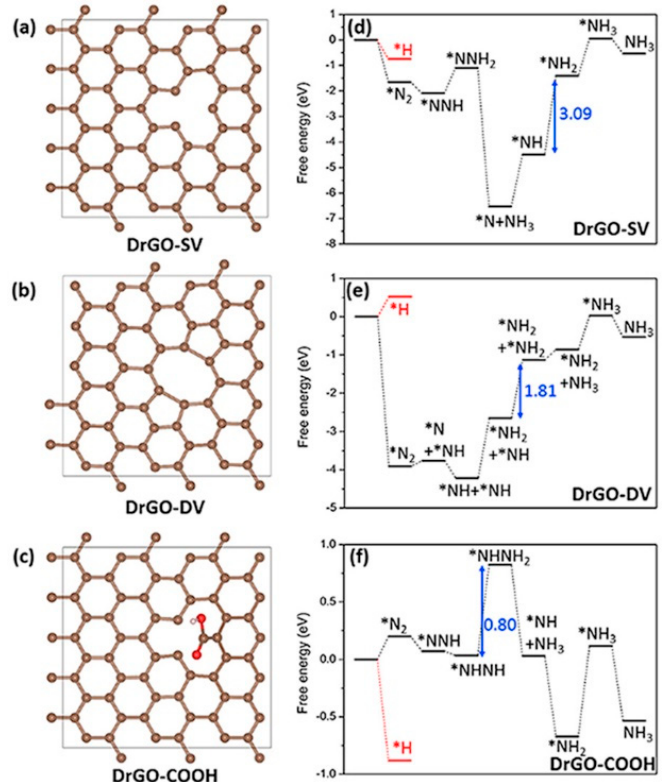
Figure 2. Different defects on DrGO: single Carbon Vacancy ( a ), double Carbon Vacancy ( b ), and carboxylic carbon ( c ). Energetics for main NRR intermediates on these defects are reported on the right side ( d – f ). Reprinted with permission from [36]. Copyright 2019 Elsevier Ltd.